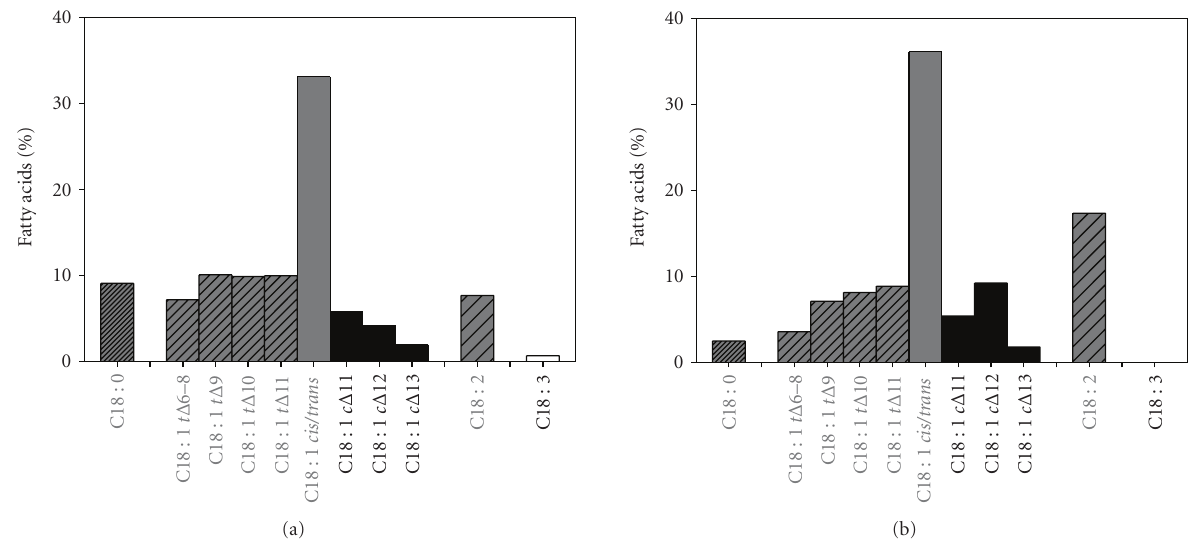
Figure 4: Distribution of the products of ECH of linolenic acid after passage of 120 C on (a) Pd/Al 2 O 3 5% (b) Pd-Co/Al 2 O 3 5%.